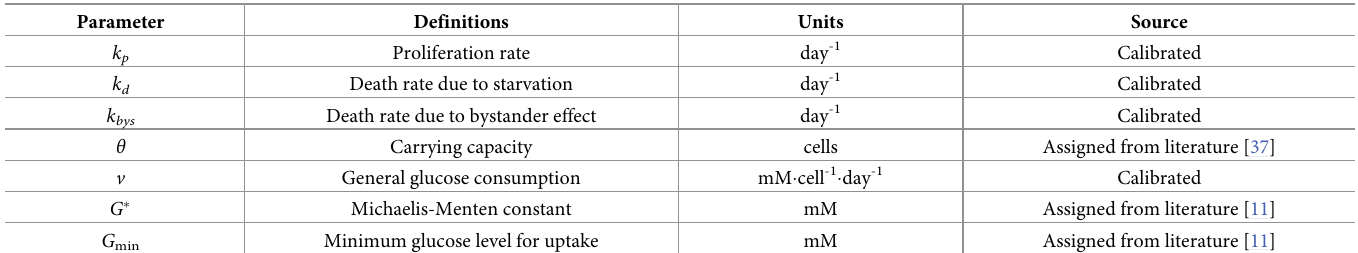
Table 1. The definitions, units, and source for the model